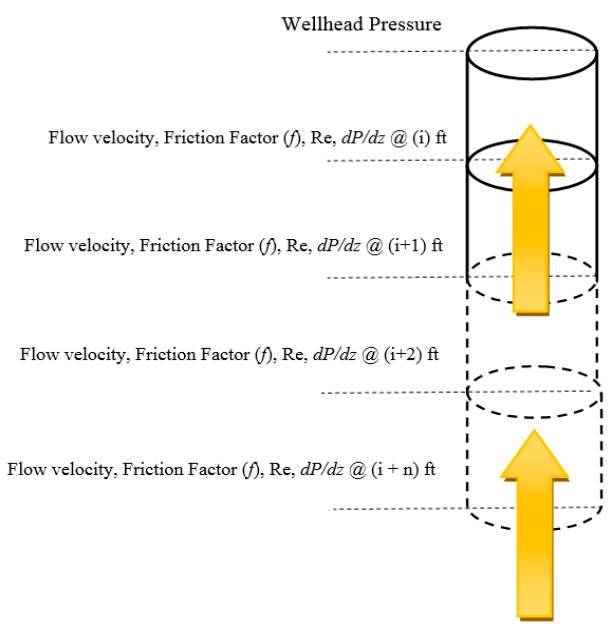
Figure 5. Stages of computational methodology.